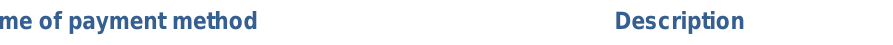
Table 6: Payment method structure in Winch (2010, Ch.